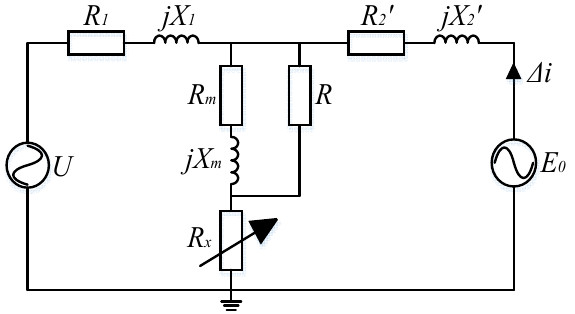
Figure 4. Equivalent model for the online detection of VT insulation.